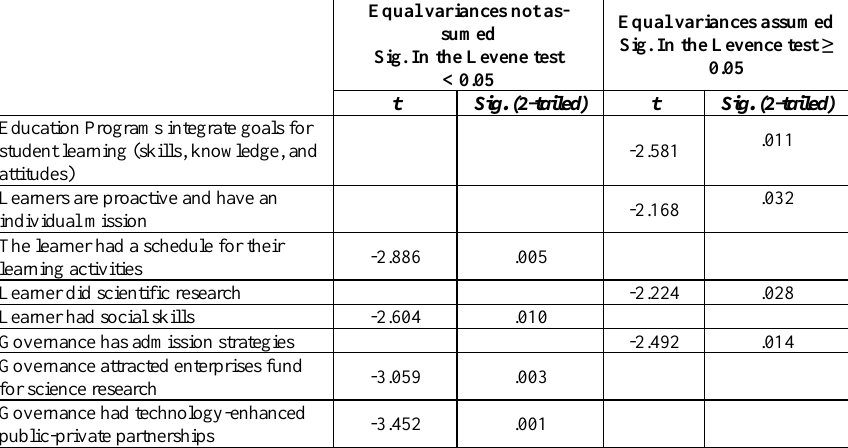
Table 7. The t -test between non-IT staff and IT staff Equal variances not as- sumed Sig. In the Levene test <